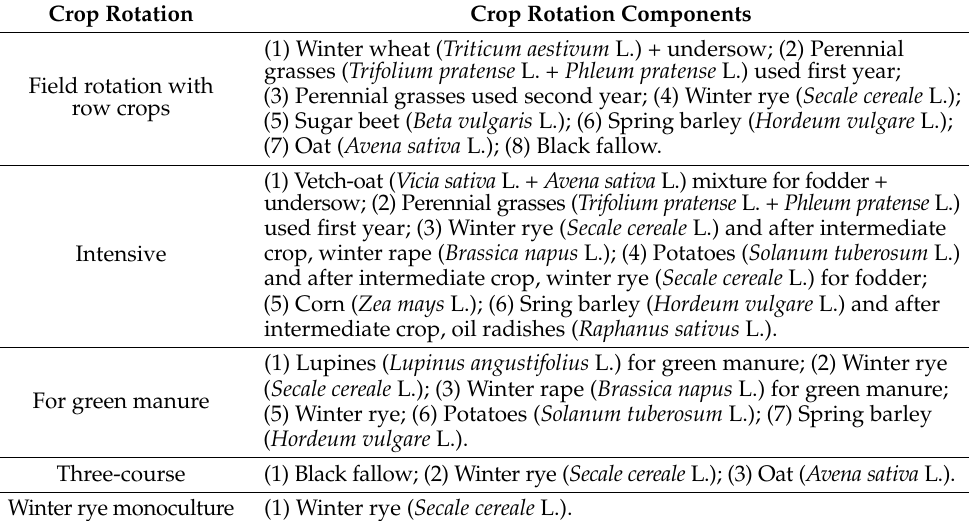
Table 1. Crop rotation sequences. Crop Rotation Crop Rotation Components Field rotation with row